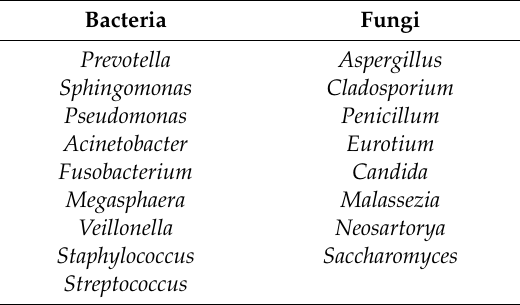
Table 1. Main bacteria and fungi genera of the lower respiratory tract microbiome of adult